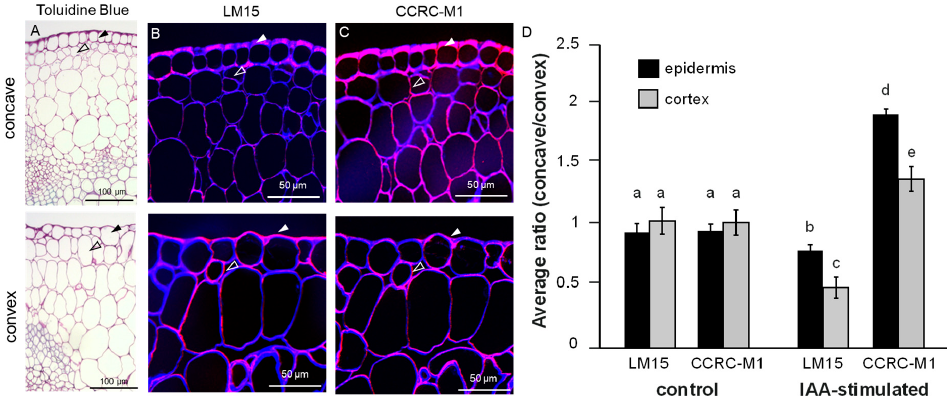
Figure 2. ( A – D ) In situ spatial distribution XyGs in pea sections. ( A ) Toluidine staining of the thin resin section through auxin-modulated pea segment. Close up pictures on the tissue morphology of the concave (shorter) and the convex (longer, auxin-modulated). Note the enlargement of the epidermal (closed arrowhead) and cortical cells (open arrowhead) in the convex site. ( B – D ) Immunolocalization of LM15 ( B ) and CCRC-M1 ( C ) epitopes in concave (upper panels) and convex (lower panels) sides of the auxin paste-modulated stem. Images are overlays of the monoclonal antibodies (mAb)-generated signal (red) and the cell wall counterstaining with β -(1,4)-glucan-specific dye Calcofluor White (blue). Note the decrease of CCRC-M1 signal, but significant increase of the LM15 signal in the epidermis and cortex of the convex side. Closed arrowhead: epidermis; open arrowhead: cortex. ( D ) Quantification of the LM15 and CCRC-M1-generated signal ratios between the concave and convex side of the indole-3-acetic acid (IAA)-stimulated stem. Signals of epidermis and cortex were analyzed separately. Two sides of the control stem (lanolin only) showed no statistically significant differences in LM15 and CCRCM1 labeling (n > 26), One-way ANOVA with Tukey’s post-hoc test with p < 0.05. Error bars represent SEM. Similar letters in the graphs mark no significant statistical difference. Different letters in the graphs mark significant statistical difference with a p -value < 0.05.